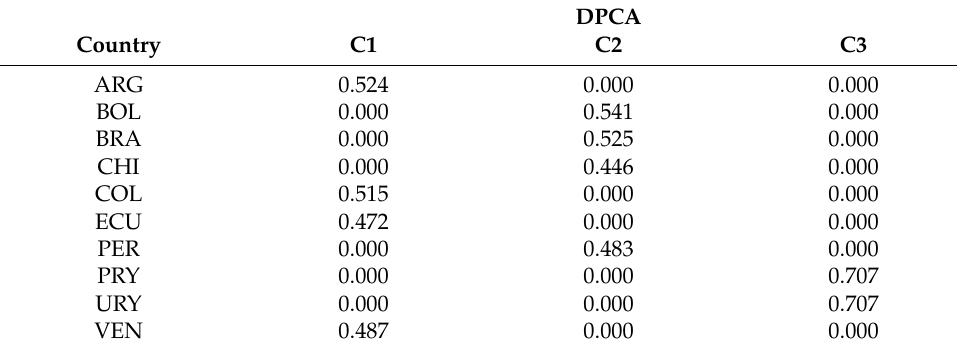
Table 3. Loading matrix for data on the number of COVID infected cases with three components (C1, C2, and C3) for the indicated country using the DPCA. DPCA Country C1 C2